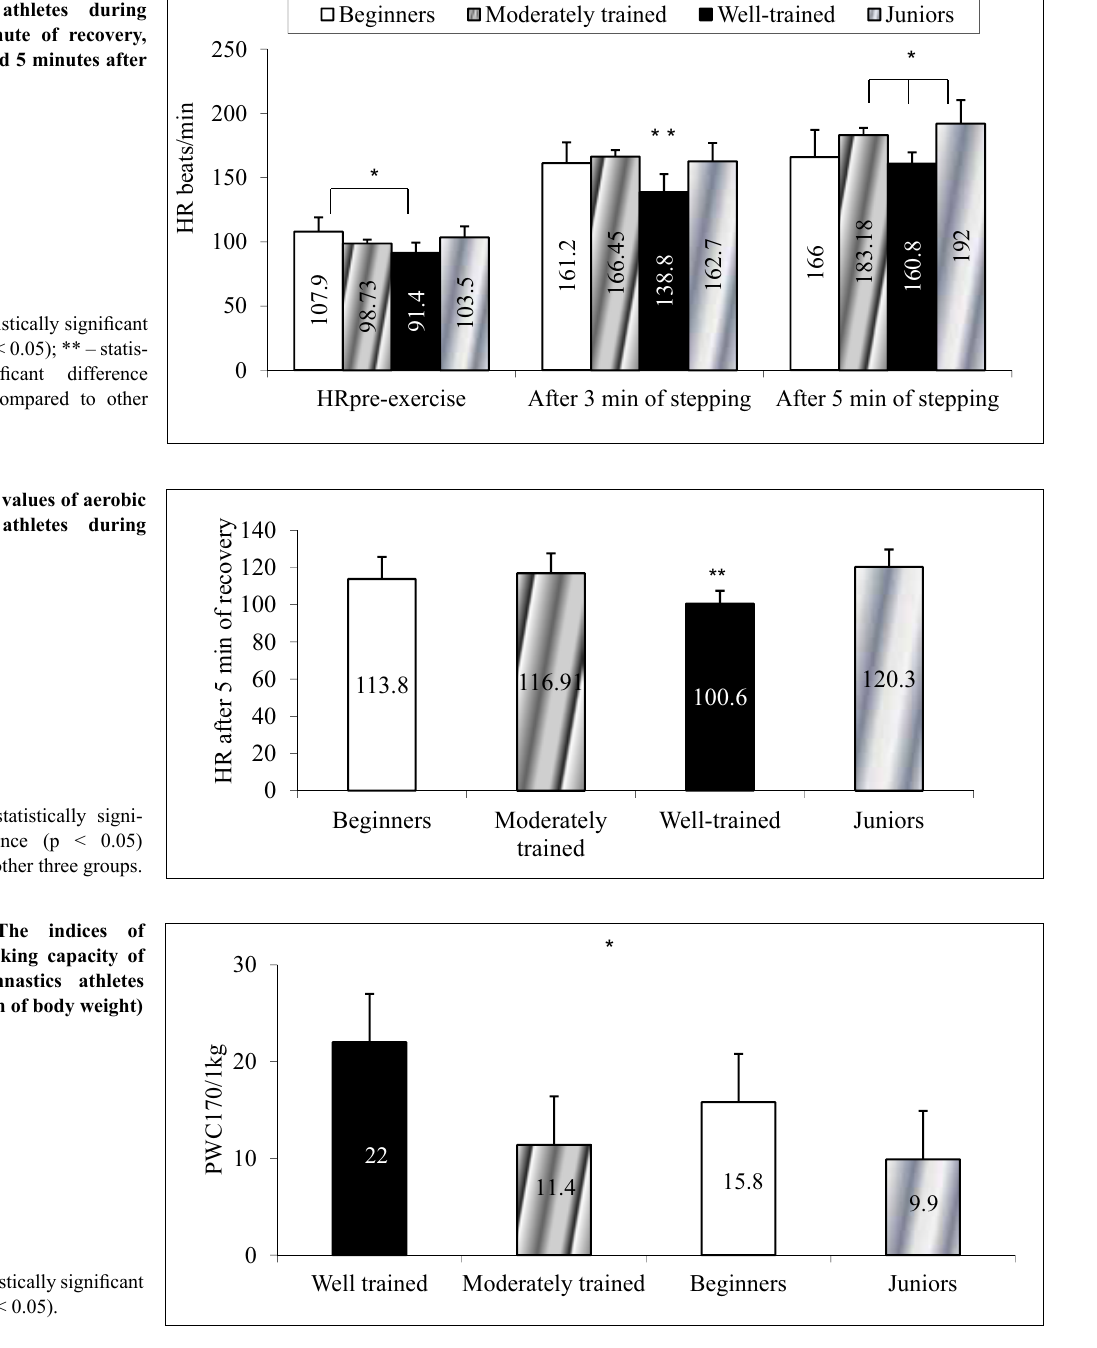
Figure 1. HR values of aerobic gymnastics athletes during